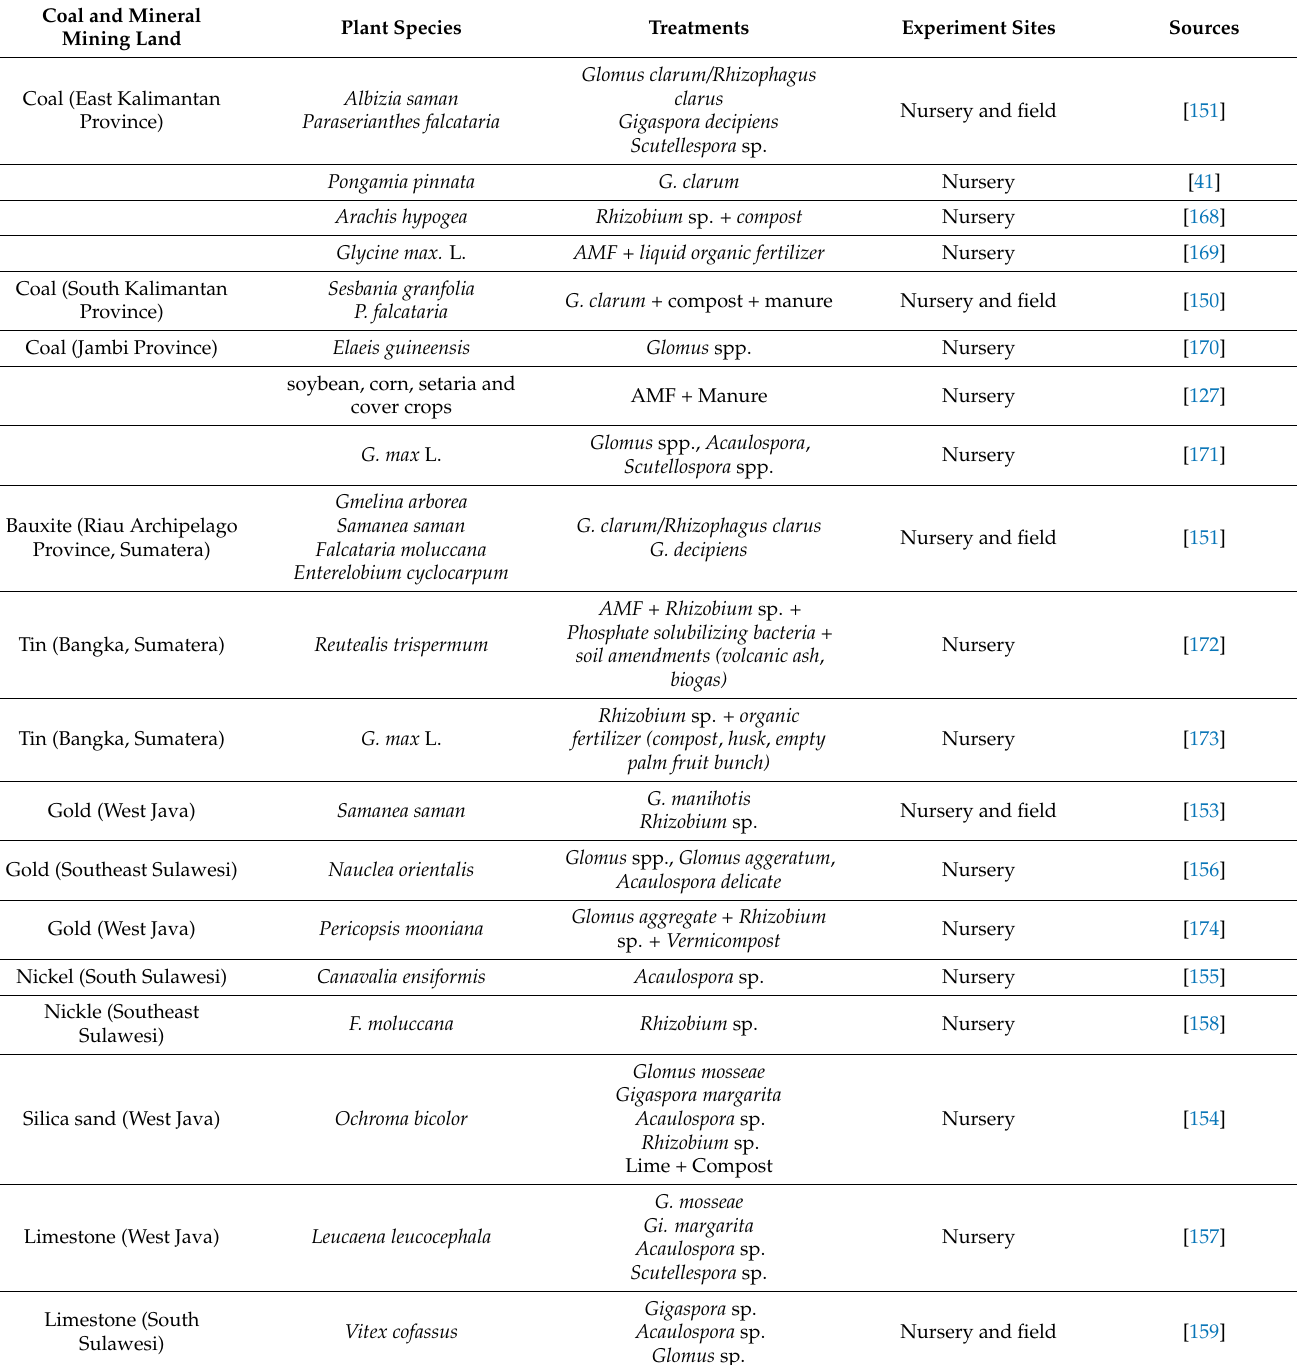
Table 1. Application of mycorrhizal fungi, Rhizobium sp., and organic fertilizer in post-coal and mineral mining lands in